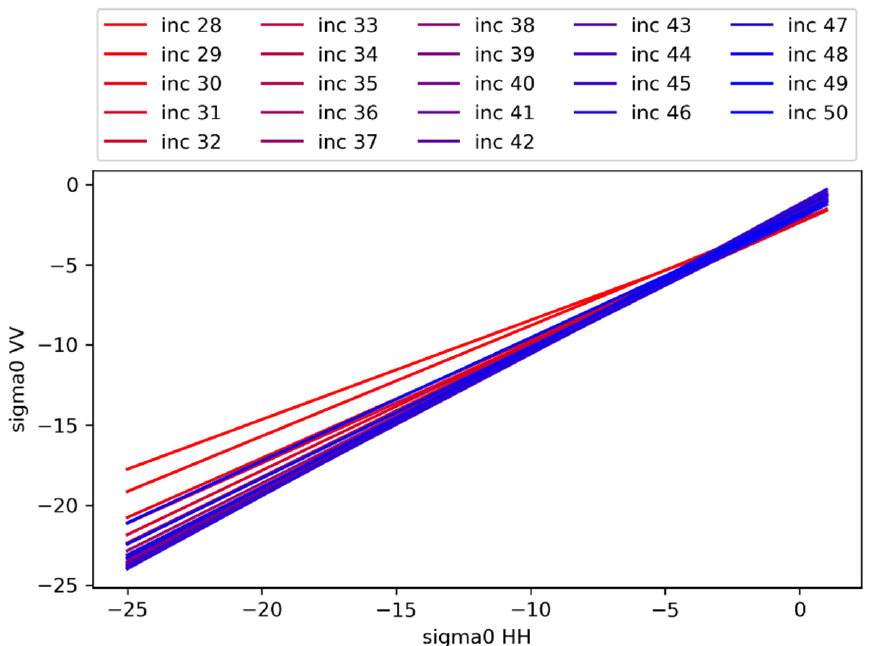
Figure 6. Illustration of the sea-ice GMFs as a function of incidence angle (truncated_inc). The sea-ice GMFs (slope and offset) are constructed as a function of incidence angle (bin size is 1 ◦ ) from the HH and VV backscatter measurements over sea ice (Figure 6). Therefore, the minimum squared distance from sea-ice backscatter to sea-ice GMF in each WVC can be expressed as follows: